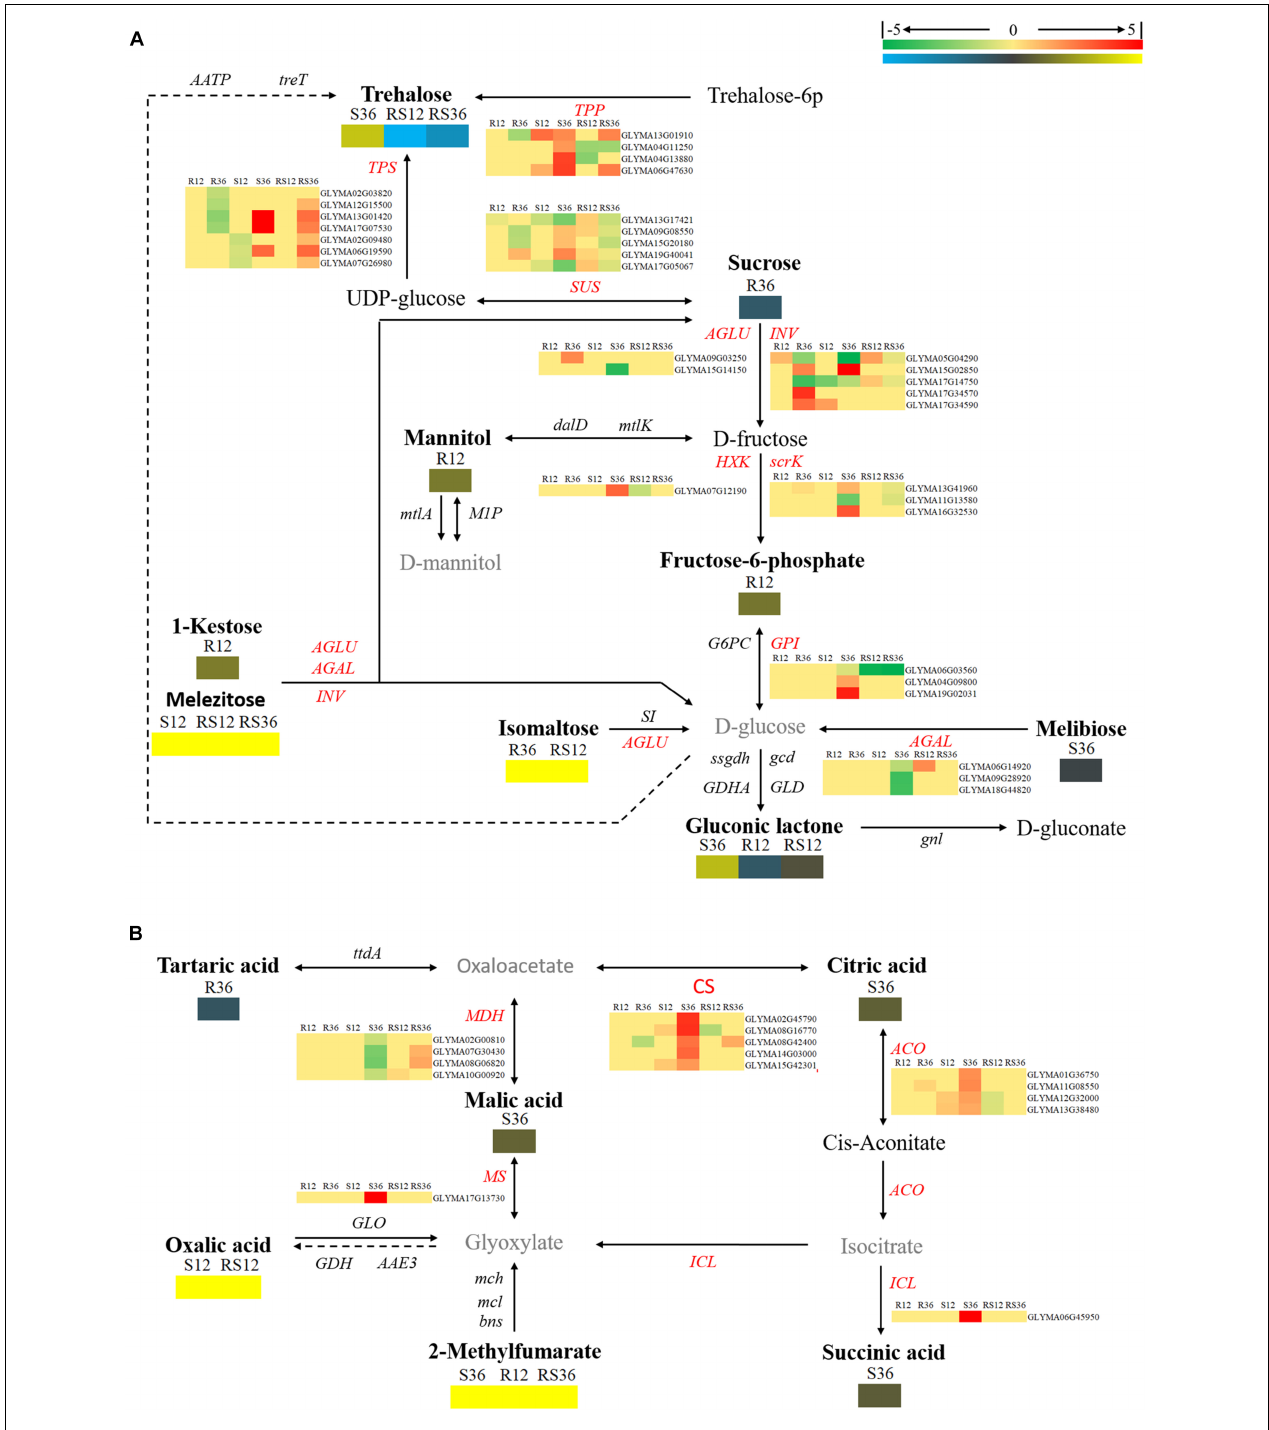
FIGURE 3 | Diagram of carbohydrate metabolism pathways with their related DEGs (differentially expressed genes) and DAMs. (A) Pathway of starch and sucrose metabolism. (B) Pathways of the citrate cycle (TCA cycle), glyoxylate and dicarboxylate metabolism. DAMs are in bold black fonts. No significantly differentially accumulated metabolites are in black fonts; unidentified metabolites are in gray fonts. The abbreviations of gene names are in italics. The log 2 Foldchange was colored using Cluster 3.0 (red for upregulated DEGs, green for downregulated DEGs, yellow for upregulated DAMs, and blue for downregulated DAMs), and the vertical columns represent R12, R36, S12, S36, RS12 and RS36, from left to right. R12: R-12h-IN vs. R-12h-CK; R36: R-36h-IN vs. R-36h-CK; S12: S-12h-IN vs. S-12h-CK; S36: S-36h-IN vs. S-36h-CK; RS12: R-12h-CK vs. S-12h-CK; and RS36: R-36h-CK vs. S-36h-CK. IN, inoculated; CK, control check. A color bar is in the upper right corner. Abbreviations of gene names are listed in Supplementary Excel S4